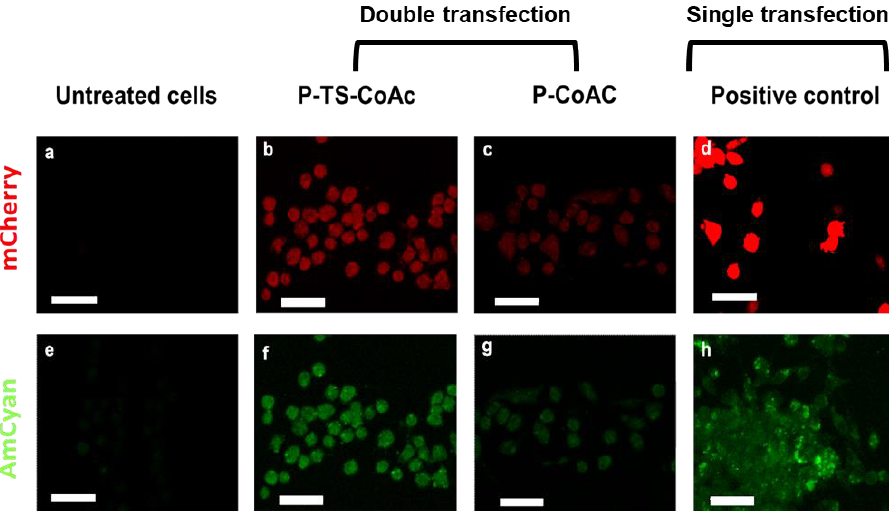
Figure 7. Assessment of transfection efficiency and gene expression of mCherry (red fluorescent reporter) and pAmCyan (green fluorescent reporter) in DC2.4 after 6 h of treatment of samples or controls followed by 48 h incubation ( a ) confocal laser scan microscopy showing expression of mCherry (red) and AmCyan(green) in DC2.4 cells treated with ( b , f ) P-TS-CoAc, ( c , g ) P-CoAc, ( d ) JetMessenger, ( h ) JetPrime compared to ( a , e ) untreated cells; the white bar = 39.64 µm. CLSM images are shown with 40% increased brightness from the original images (obtained with identical laser intensity settings for all samples).